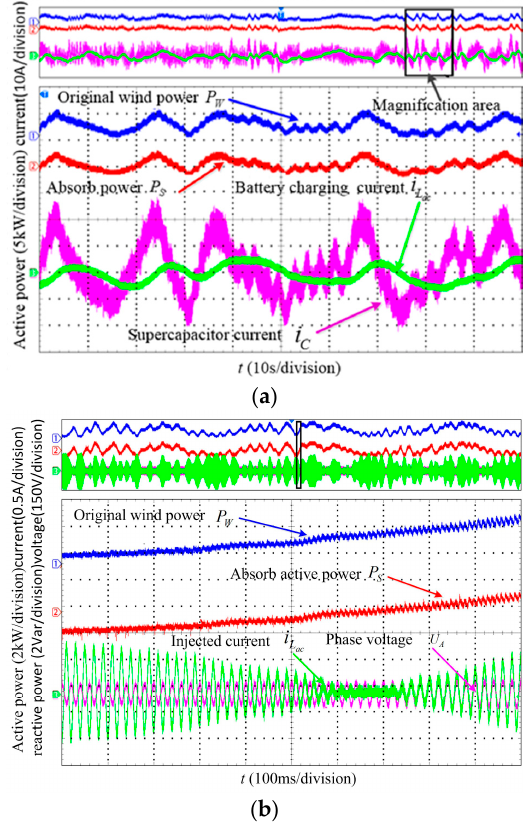
Figure 16. Experiment results with active power regulation. ( a ) In scenario 1; ( b ) In scenario